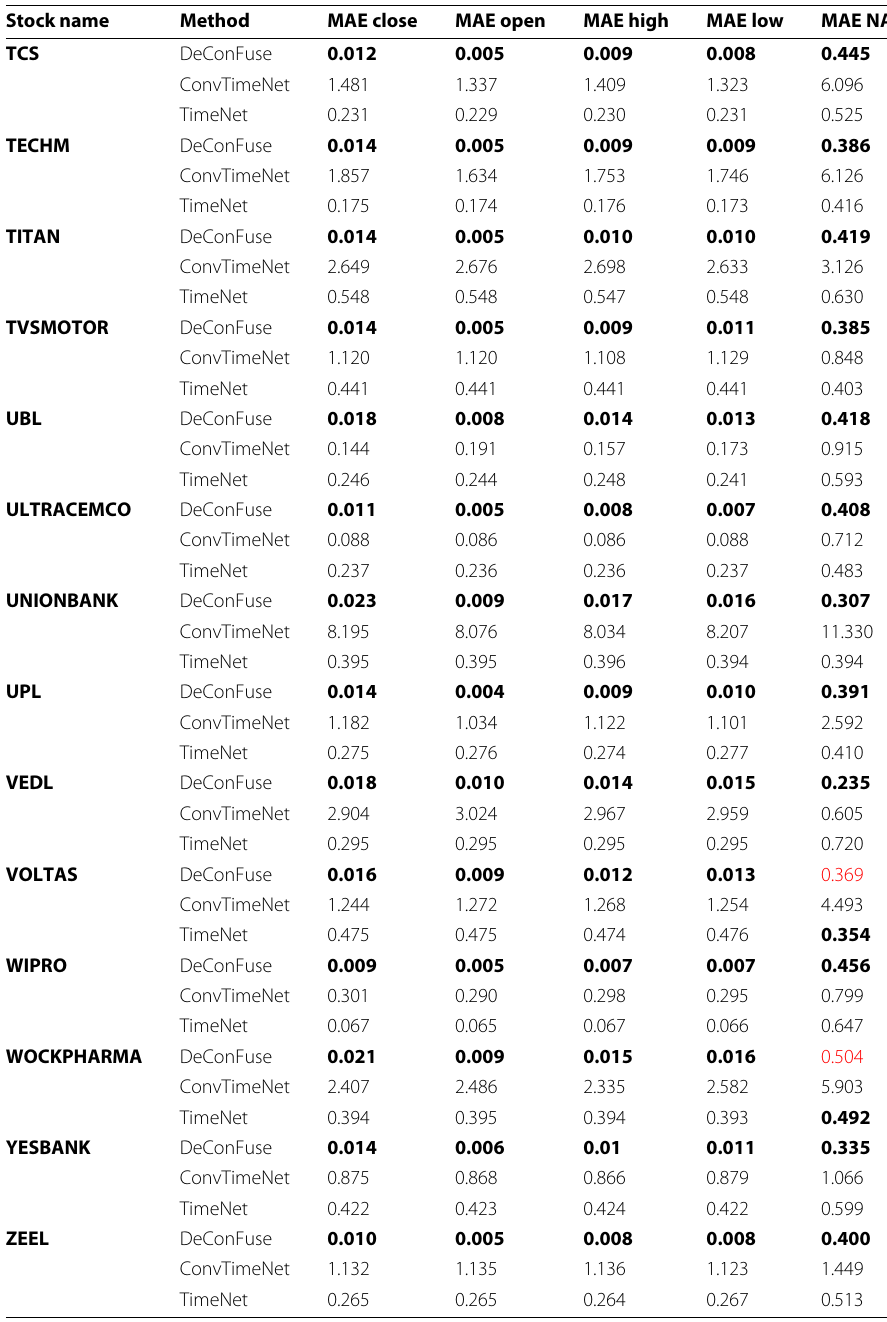
Table 5 Stock-wise forecasting results ( Continued